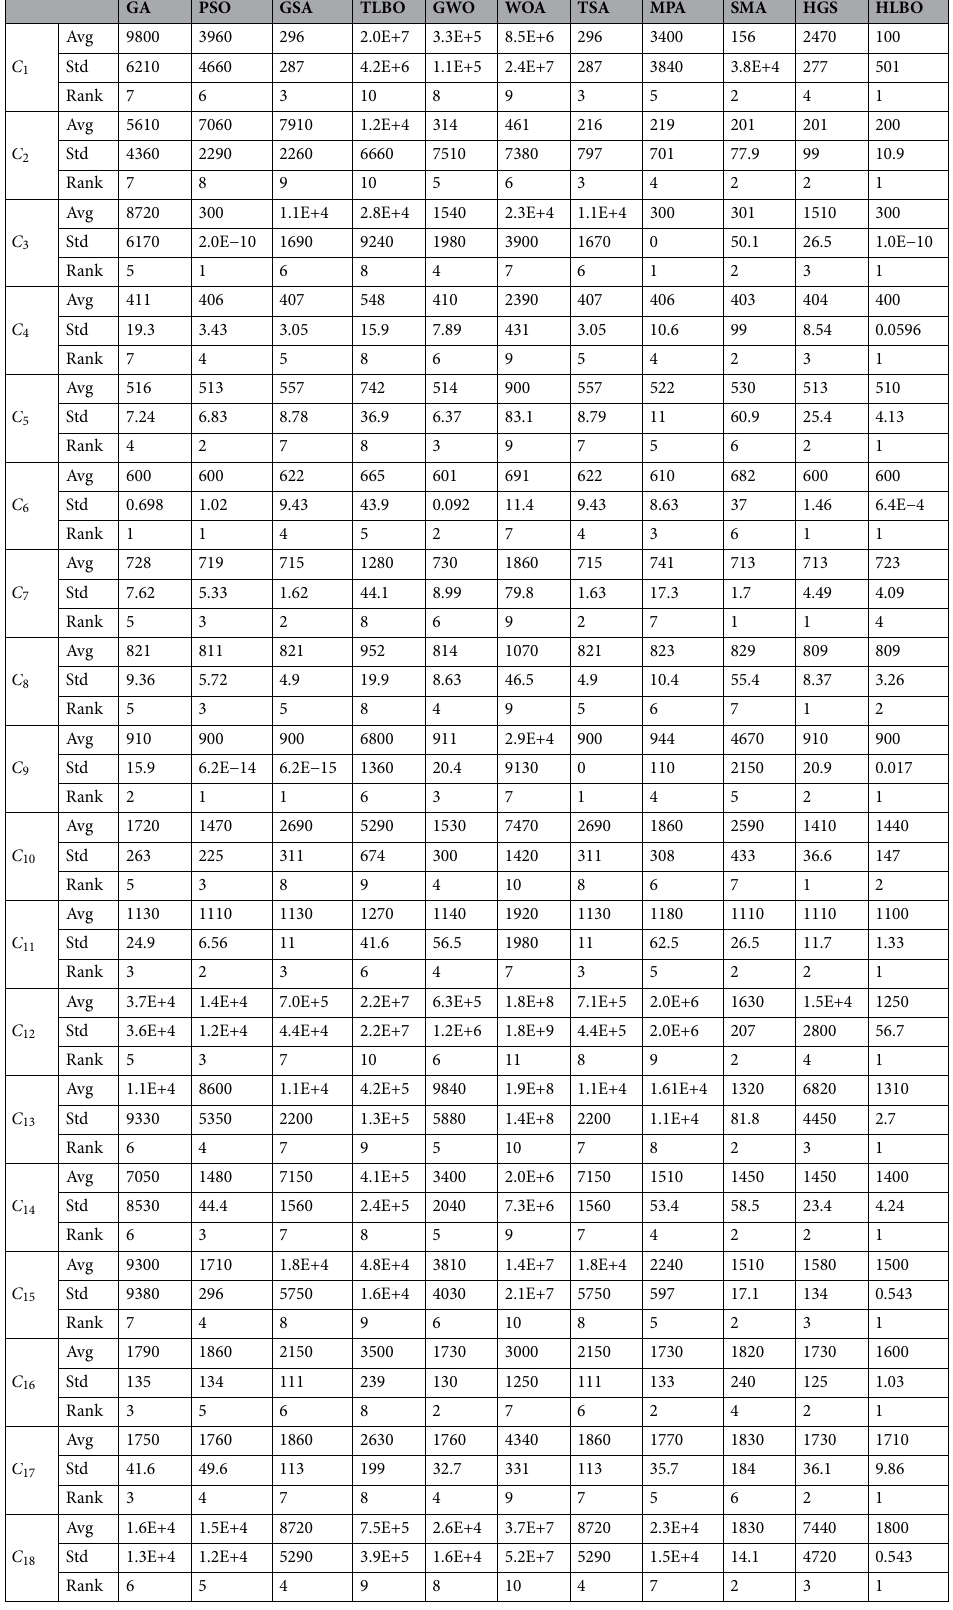
Table 6. Evaluation results of IEEE CEC 2017 objective functions C 1 to C 18